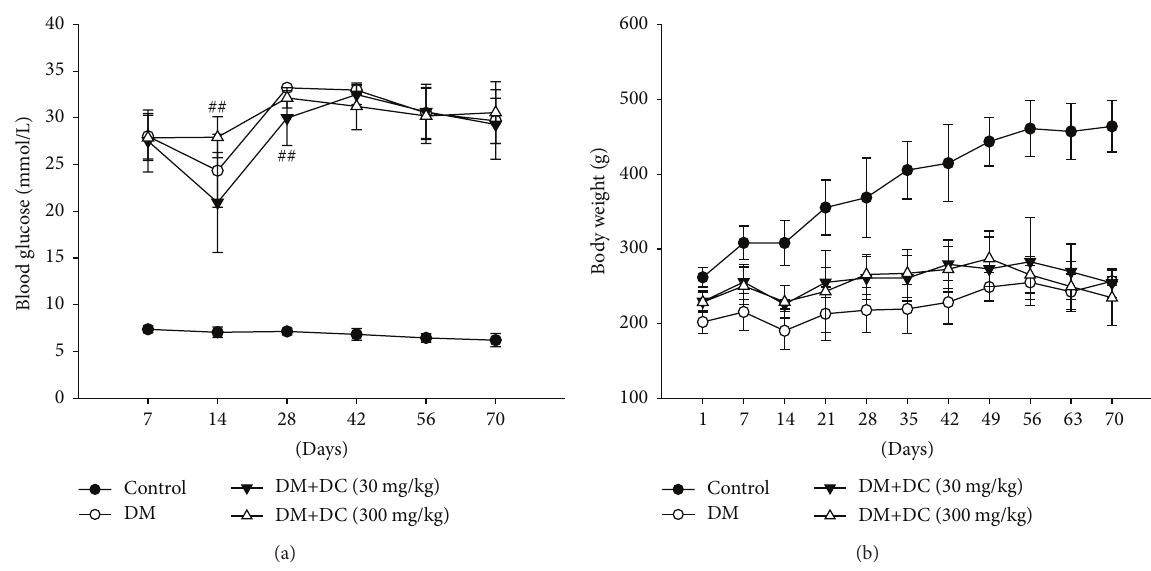
Figure 1: Analysis of serum glucose level and body weight. (a) Serum glucose level; (b) body weight. Data are expressed as means ± SD ( 𝑛 = 10 for control, 𝑛 = 7 for DM, 𝑛 = 9 for DM+DC 30mg/kg, and 𝑛 = 8 for DM+DC 300 mg/kg). ## 𝑃 < 0.01 compared to DM without DC.